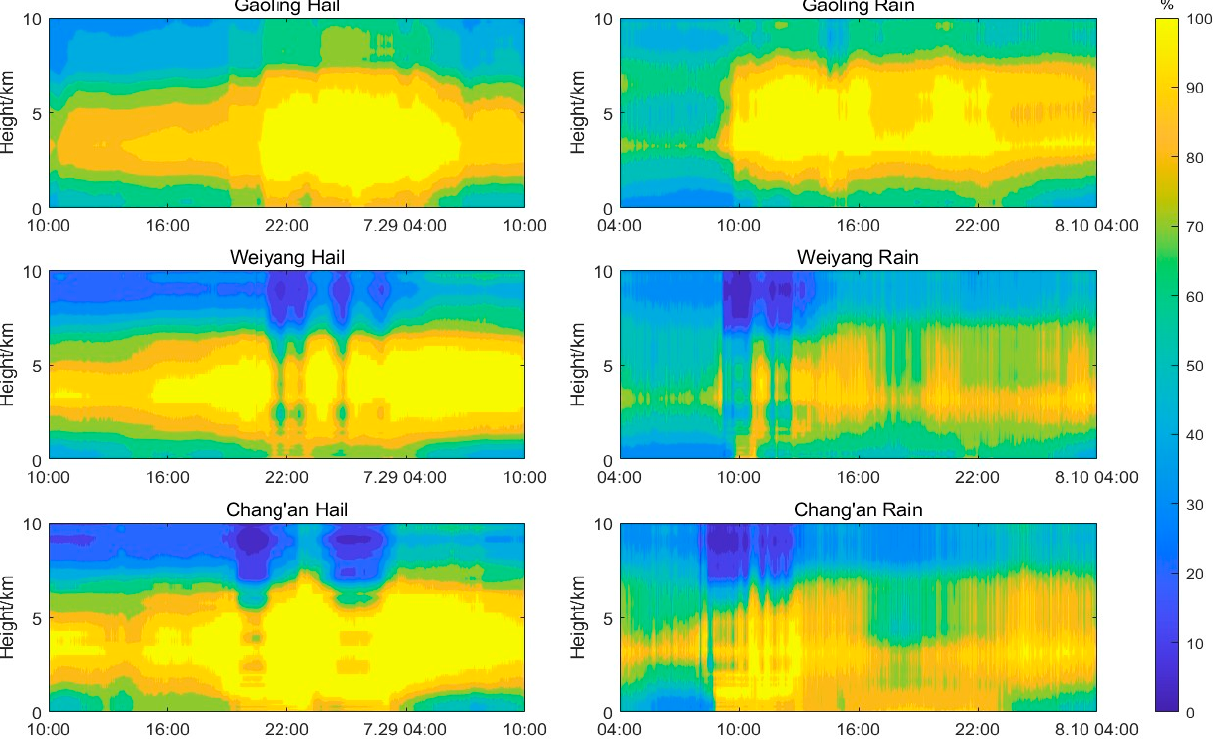
Figure 5. Changes in relative humidity profiles during hailstorms ( left , starting at 4:00 p.m. UTC on 27 July 2019, as shown in Figure 4) and rainfall ( right , rainfall process, starting at 4:00 p.m. UTC on 8 August 2018, as shown in Figure 4) in the Gaoling, Weiyang, and Chang’an districts.